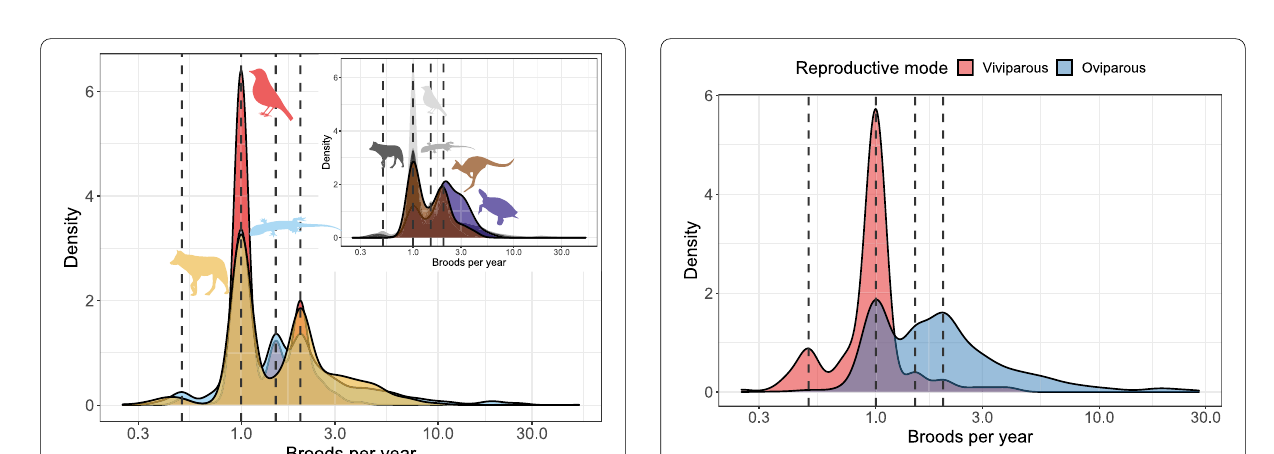
Fig. 8 Parity mode and broods per year for the Squamata. Dashed vertical lines represent (from left to right) 0.5, 1, 1.5 and 2 broods per year. The x axis is in log 10